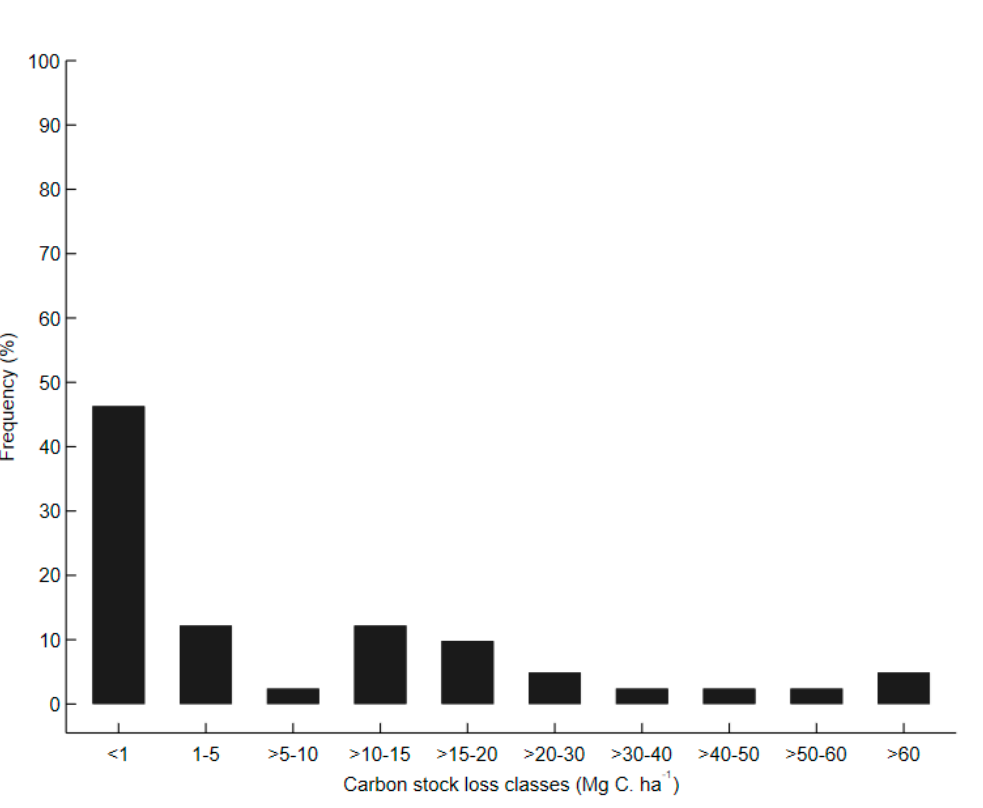
Figure 3. Frequency distribution of the carbon stock loss (Mg C. ha − 1 ) from trees measured from 41 rectangular transects damaged by mining.